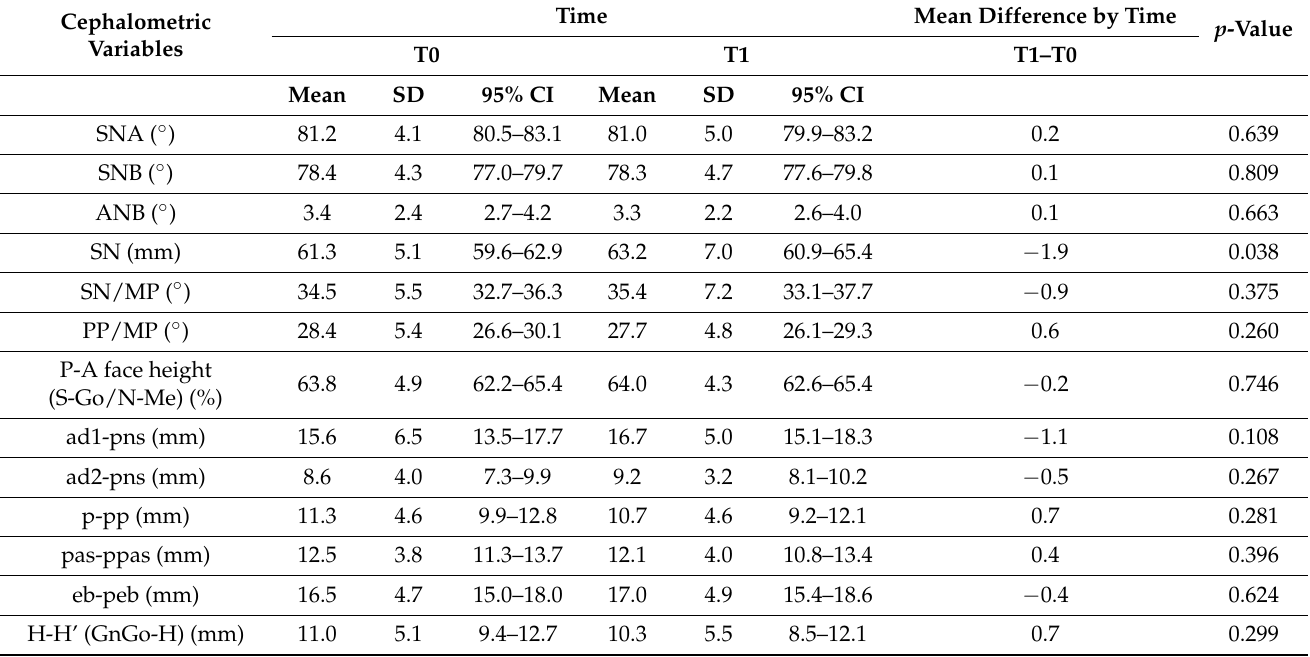
Table 3. Cephalometric variables in control group at time T0 and T1, expressed as mean and standard deviation (SD) and their 95% confidence interval